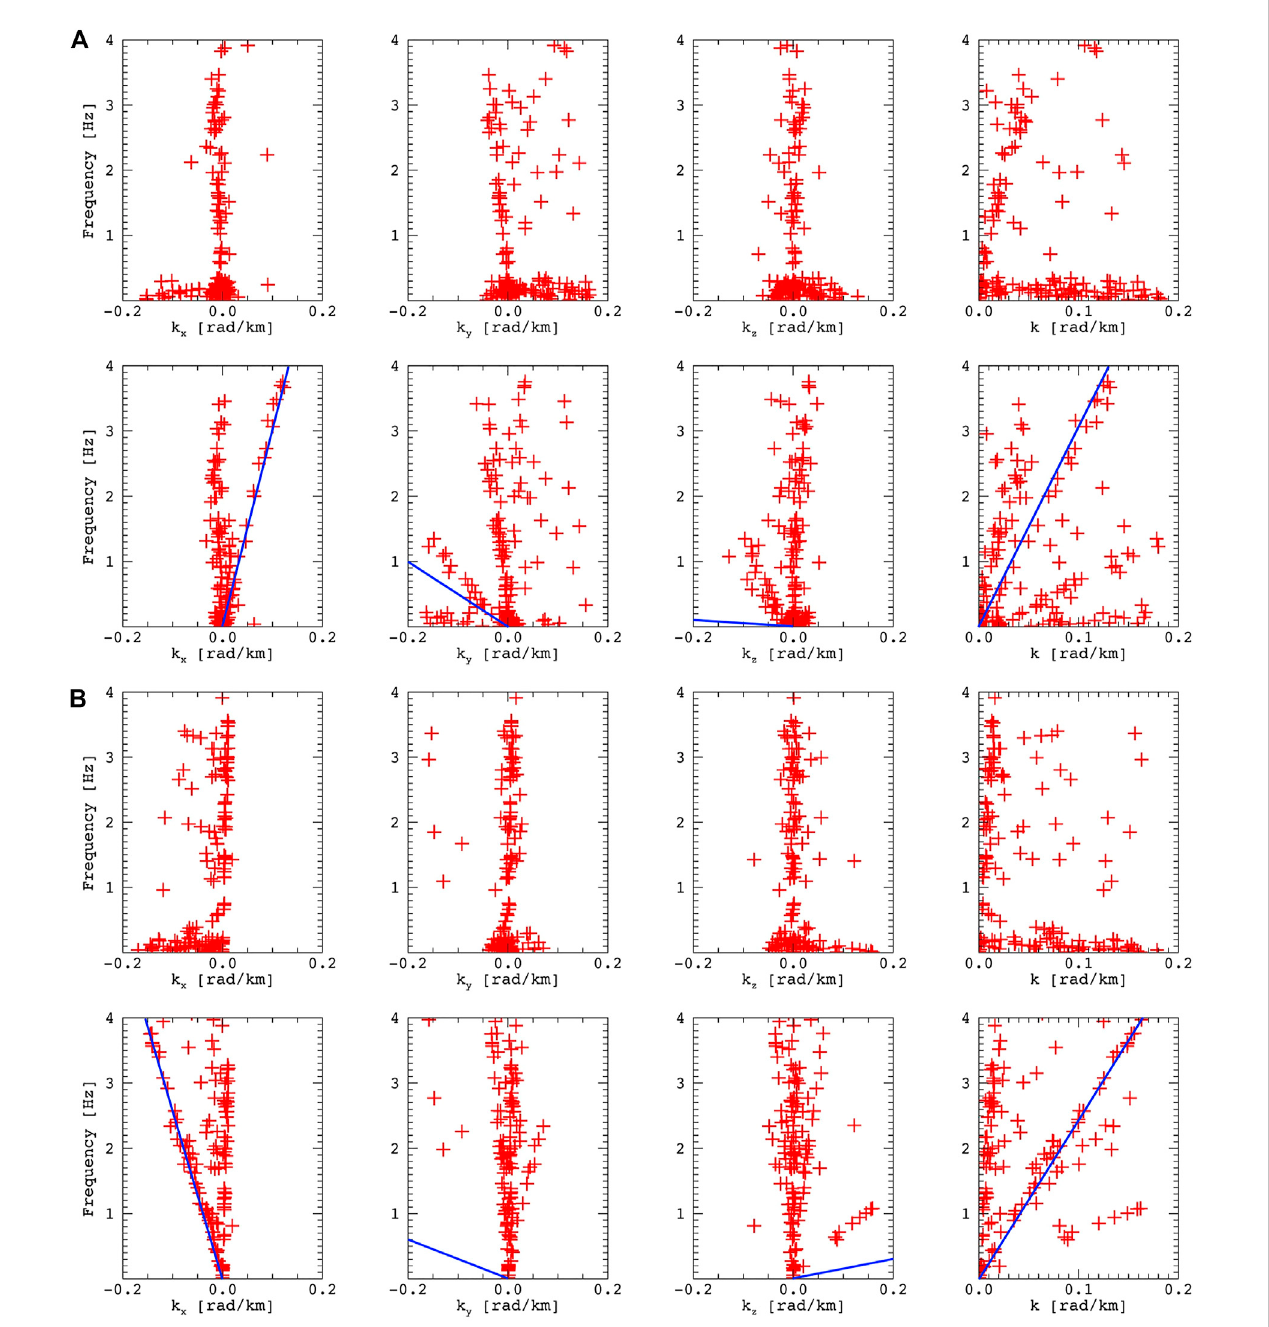
FIGURE 4 (cid:22) → (A) f – k dispersion patterns of δ B obtained by the wave surveyor method for the fi rst event and (B) for the second fl appingevent on 2020/08/26. The distributions with blue lines are plotted taking into account the Doppler shift.The blue straight lines indicate the zero frequency in the spacecraft reference